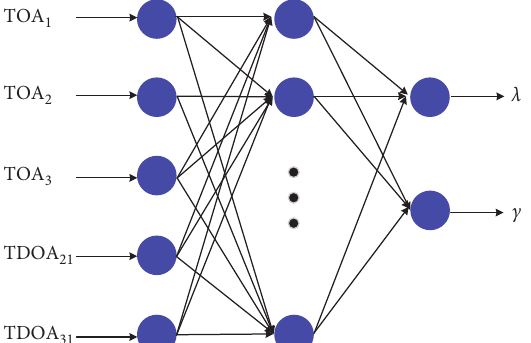
Figure 5: Structure of multilayered neural network for wireless positioning.